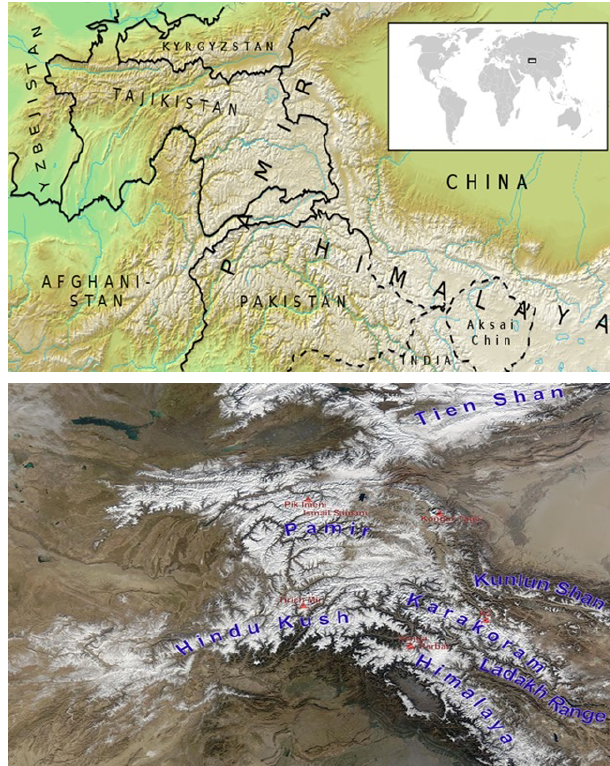
Figure 1. Maps of Mountain Pamir. Sources: (a)